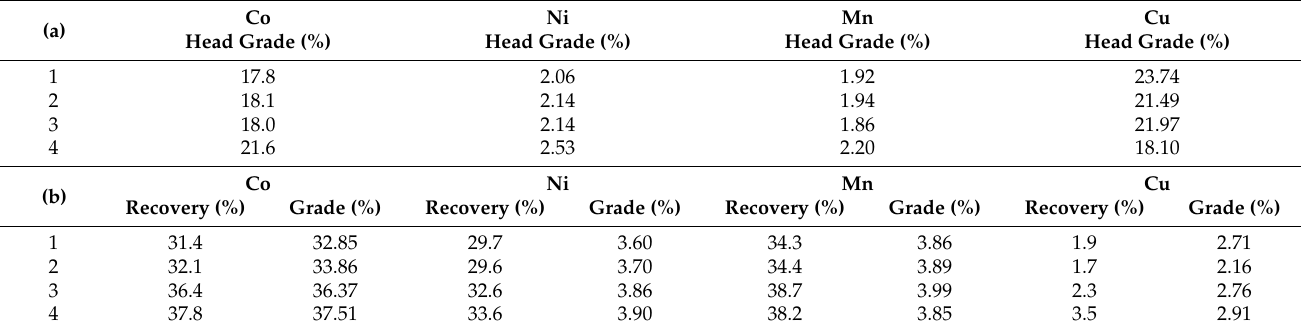
Table 4. (a) The experimental specific head grades of Co, Ni, Mn, and Cu in the feed. (b) The grades and recoveries for Co, Ni, Mn, and Cu in the 0–1 min froth concentrate.